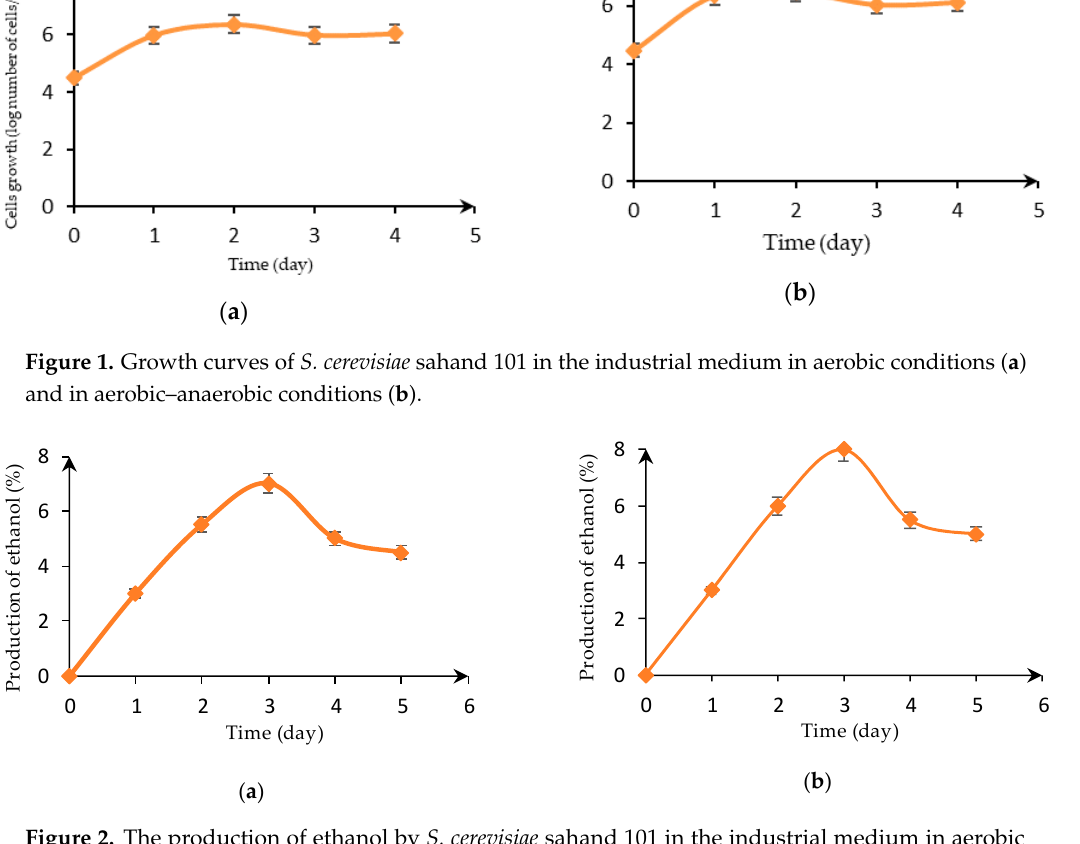
Figure 2. The production of ethanol by S. cerevisiae sahand 101 in the industrial medium in aerobic conditions ( a ) and in aerobic – anaerobic conditions ( b ).